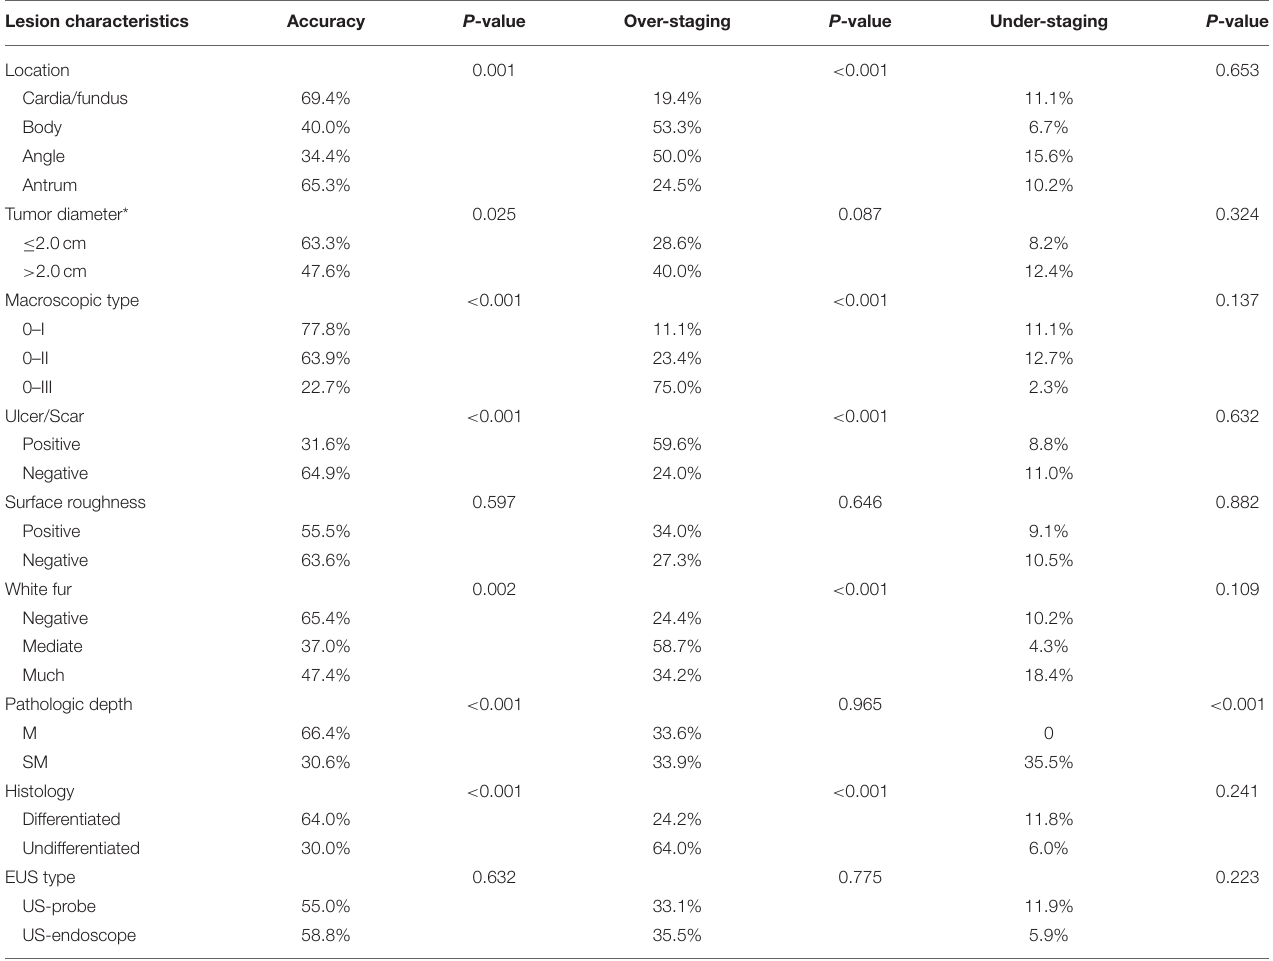
TABLE 3 | The accuracy, over-staging, and under-staging rates of EUS for diagnosing EGC invasion depth and univariate analysis of risk factors affecting the diagnostic performance of EUS. Lesion